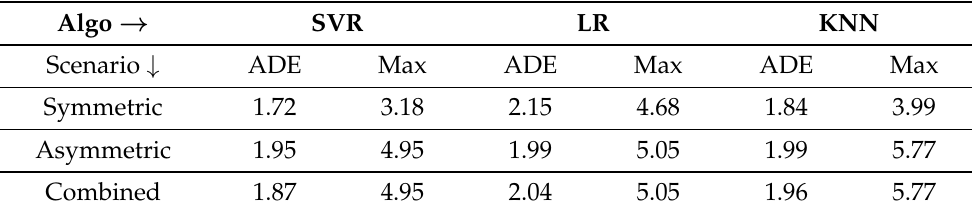
Figure 8. ADE at 48 TPs and ADE for asymmetric scenario. Table 7. ADE and maximum localization error at any TP for three